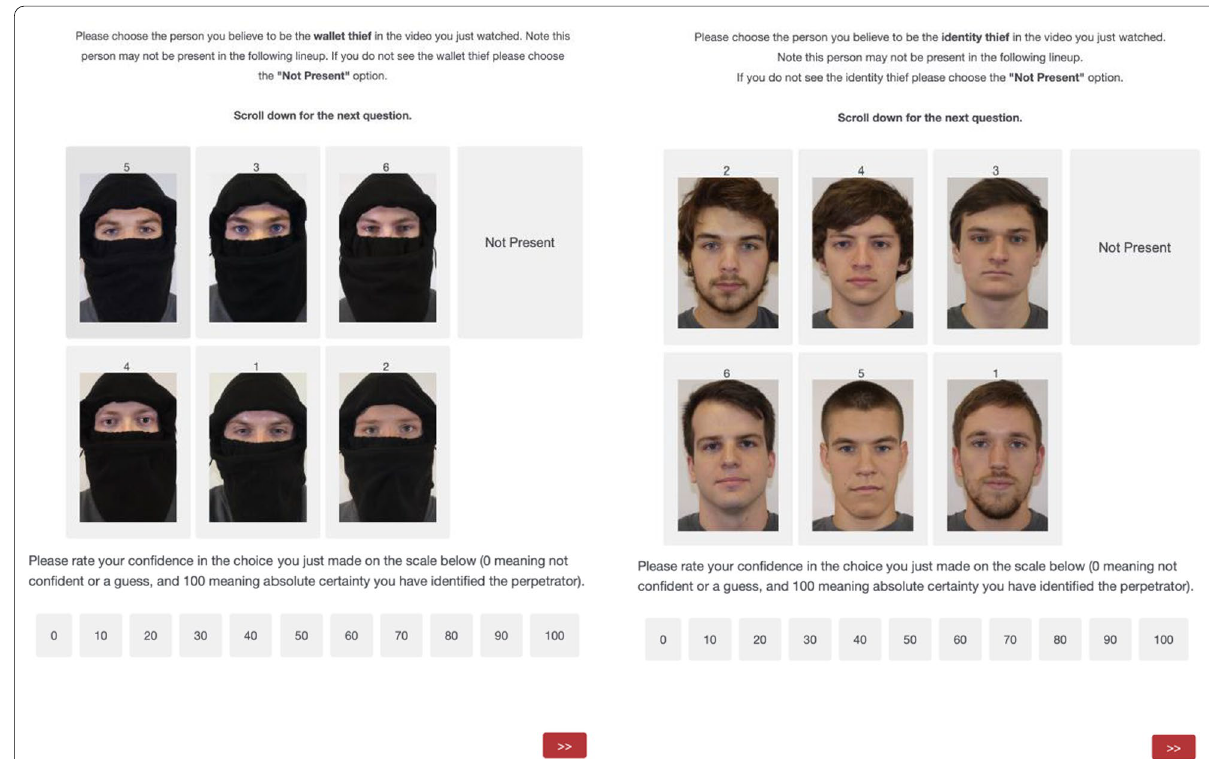
Fig. 2 An example of a masked lineup and an unmasked lineup. The two lineups shown here involved different